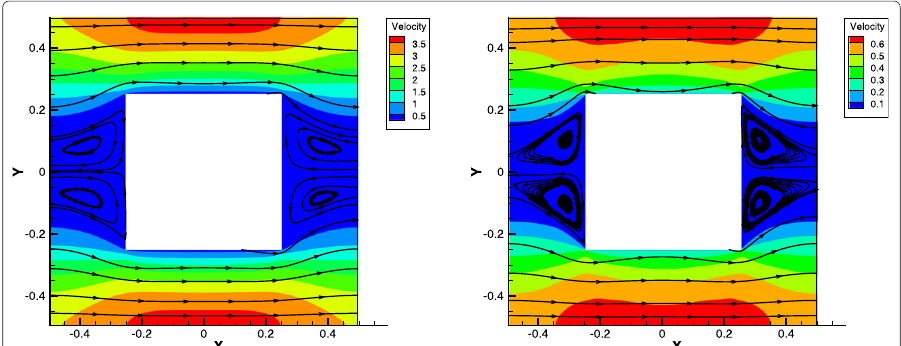
Fig. 7 The streamline and velocity magnitude of the micro flow through periodic square cylinders. Left figure shows the solution with Knudsen number Kn = 1.0 × 10 − 1 , and right figure shows the solution with Knudsen number Kn = 1.0 × 10 −